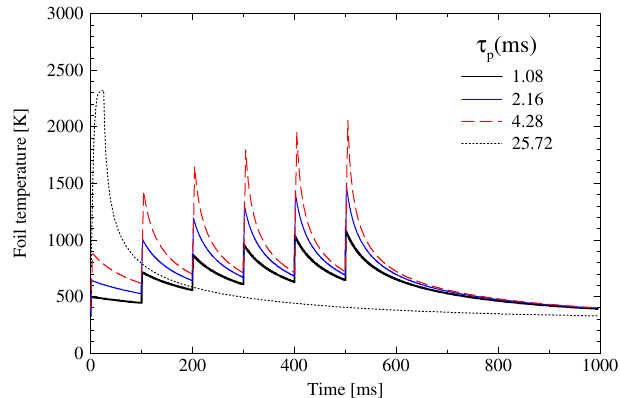
FIG. 10. Calculated temperature distributions for the 600 - (cid:3) g = cm 2 corner carbon foils of different transverse sizes (painting scenario C ) irradiated with an 8-GeV proton beam at normal incidence.